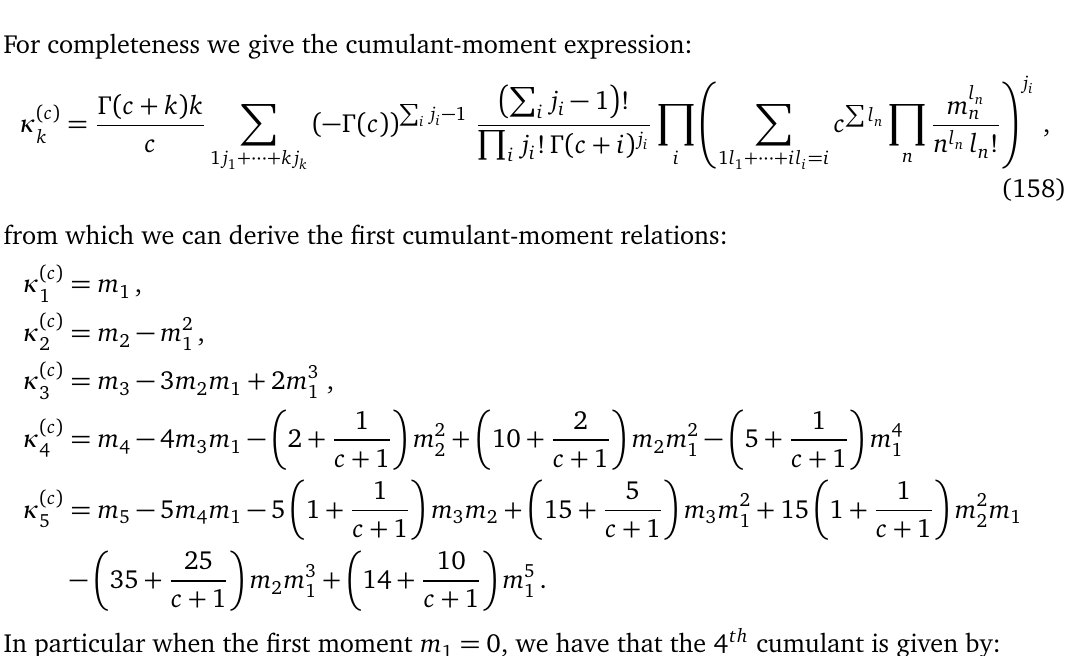
Figure 1: Plots of numerical approximations of the c-convolution of the uniform dis- tribution (a) the semi-circle (b) and the symmetric Bernoulli distribution (c) with itself for different values of c . The dashed line corresponds to the classical convolu- tion and the dotted line to the free convolution limiting